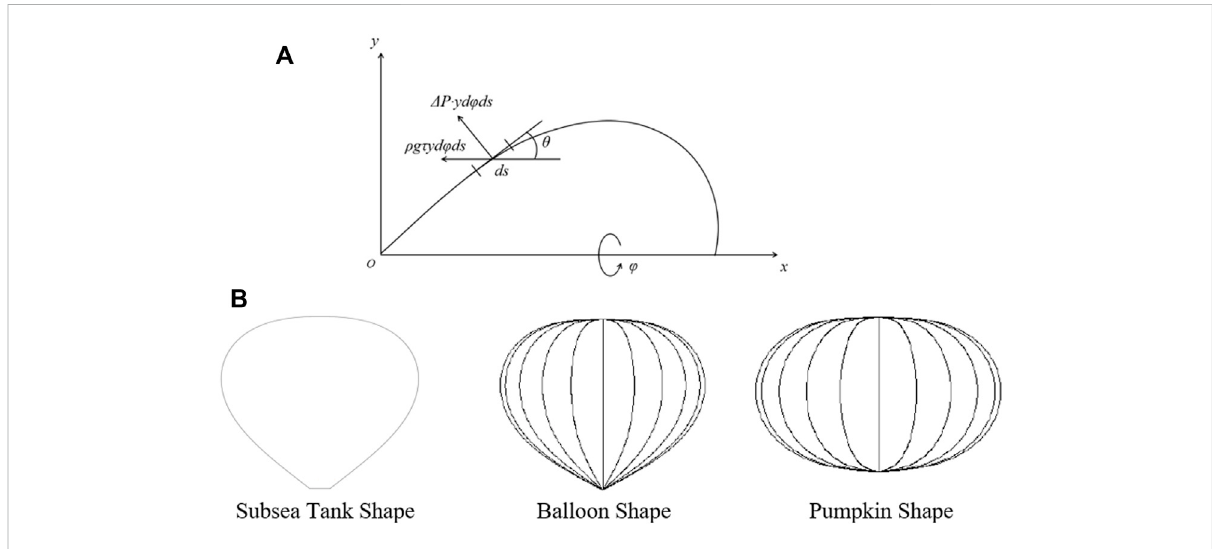
FIGURE 1 Natural tank shape of (A) the coordinate system for shape fi nding and (B) the pro fi le for the balloon and the underwater